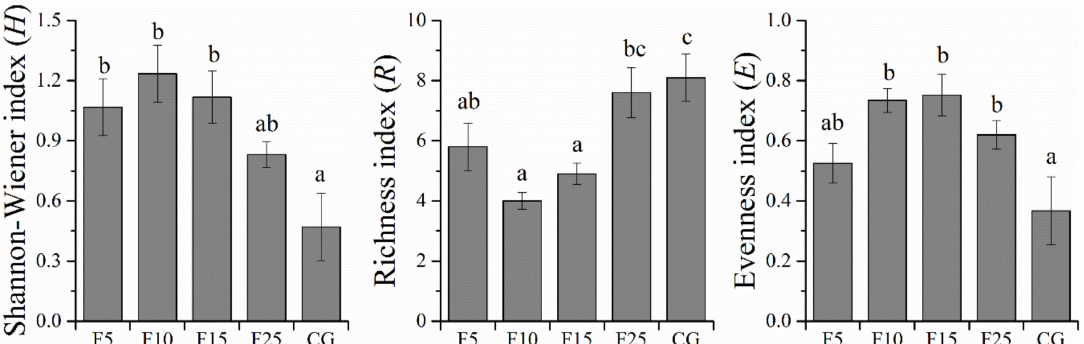
Figure 7. The Shannon-Wiener index (H), Richness index (R), and Evenness index (E) of communities in F5 (enclosed 5 years), F10 (enclosed 10 years), F15 (enclosed 15 years), F25 (enclosed 25 years), and CG (continuously grazed)